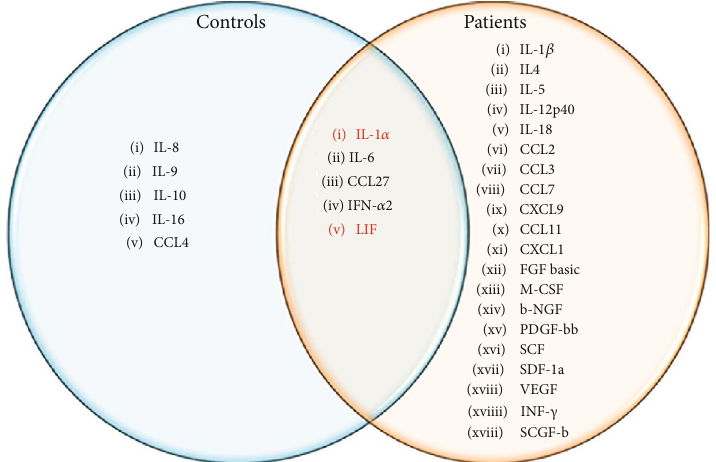
Figure 3: Cytokines expressed commonly and uniquely in serum and CSF of MS and non-MS controls. Red highlighted cytokines are downregulated in serum as compared to cerebrospinal fl uid. The rest are upregulated in serum as compared to cerebrospinal fl